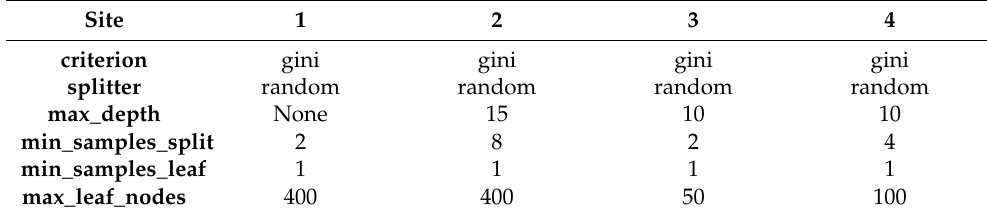
Table 8. Best parameters obtained by GridSearchCV.